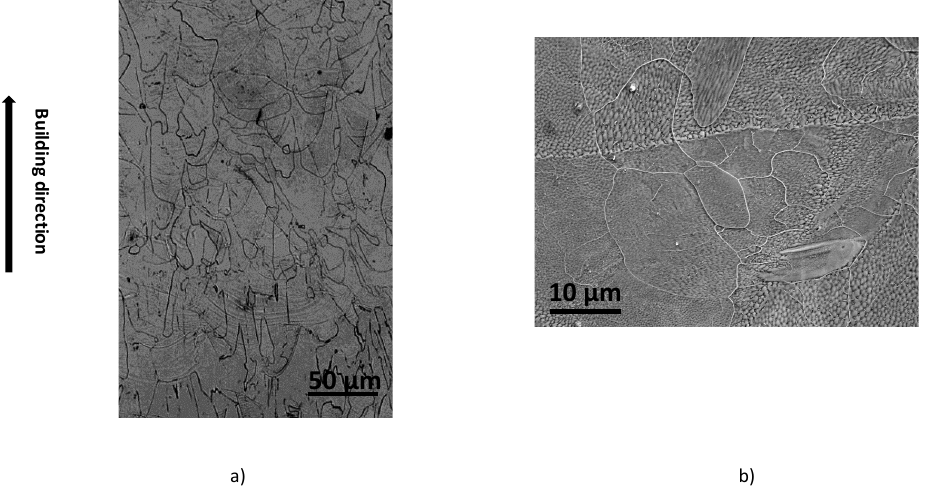
Figure 2. OM ( a ) and SEM ( b ) observations showing the single β microstructure of the as-LB-PBFed Ti42Nb alloy manufactured at 90 ◦